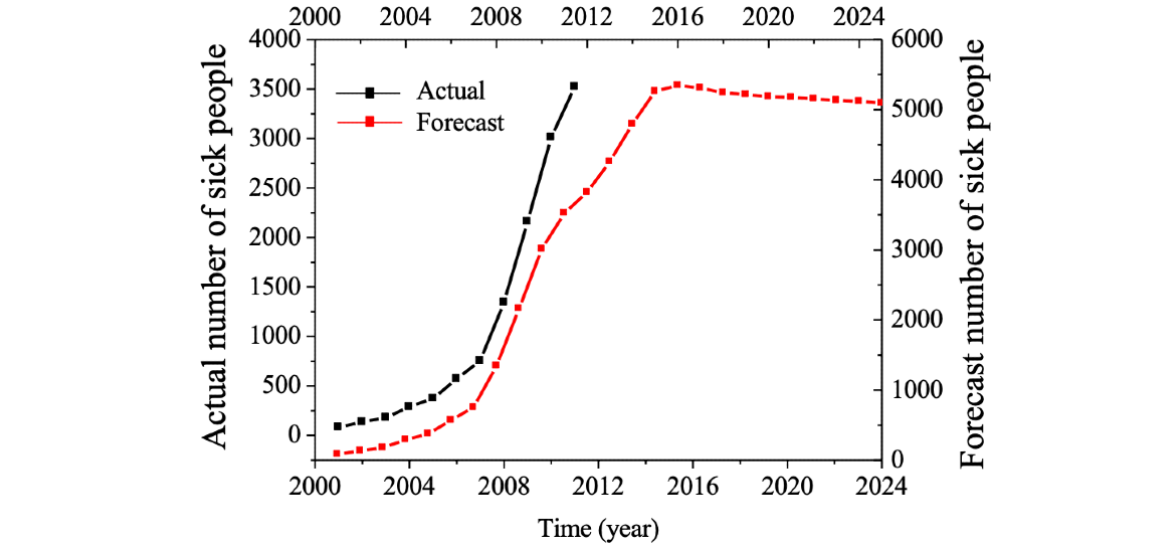
Figure 2. Fitting and short-term prediction of Brucellosis cases. This figure shows the relationship between the number of brucellosis cases and time in the region, and the appropriate number of measures required to obtain a forecast of the number of future brucellosis cases.